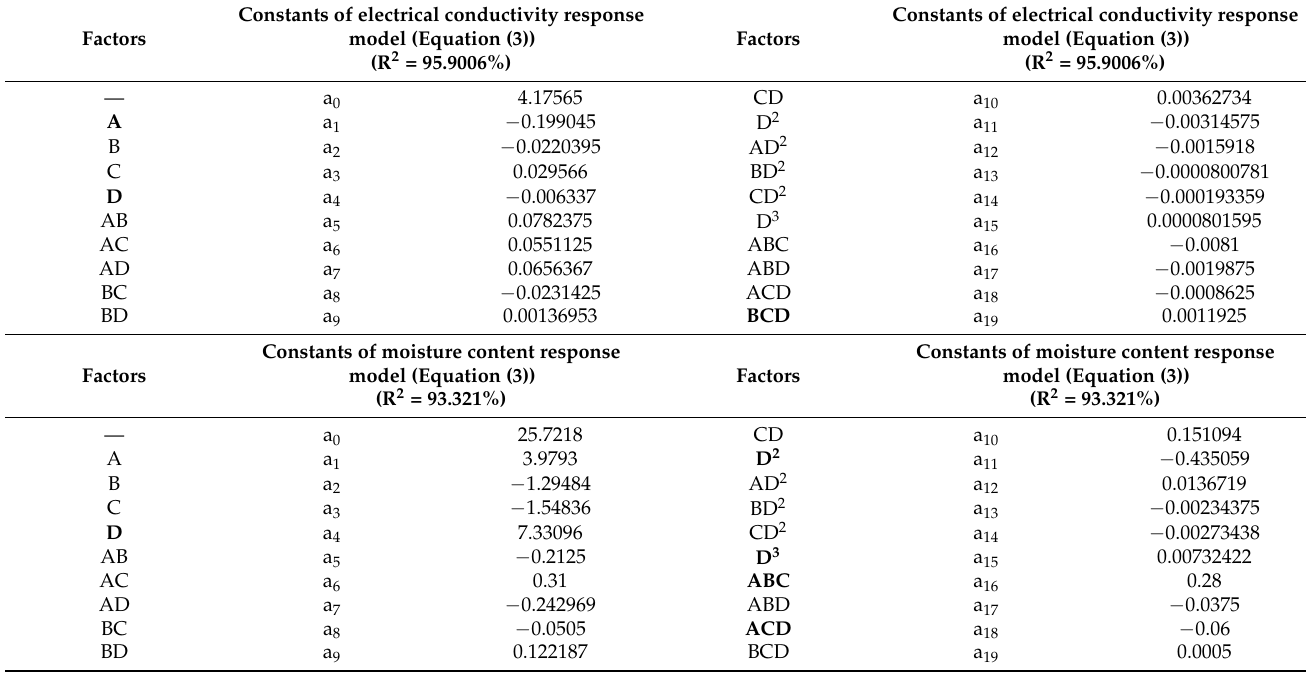
Table 7. Response model constants of electrical conductivity, moisture content and